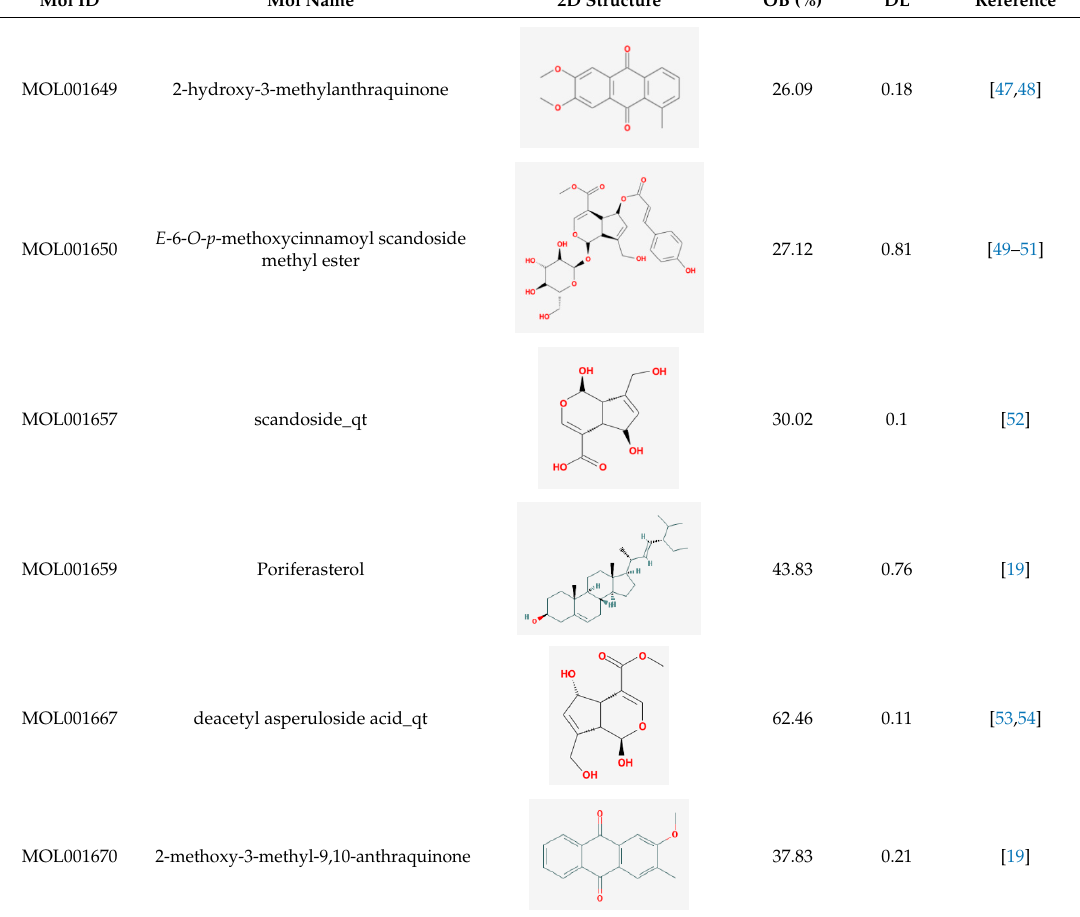
Table 1. Active ingredients of Hedyotis diffusa Willd (HDW).